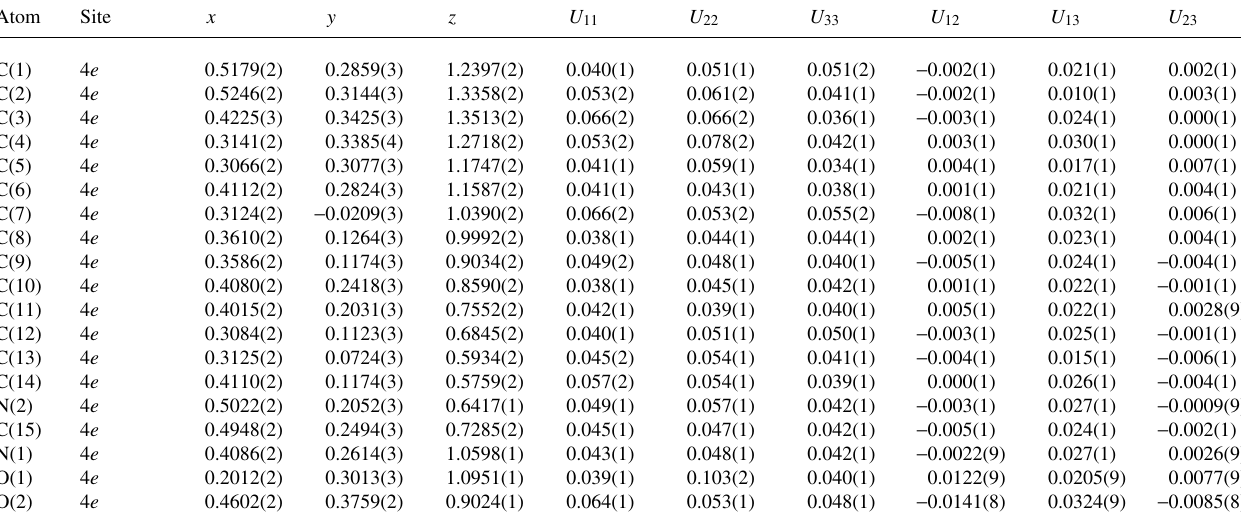
Table 3. Atomic coordinates and displacement parameters (in Å 2 )